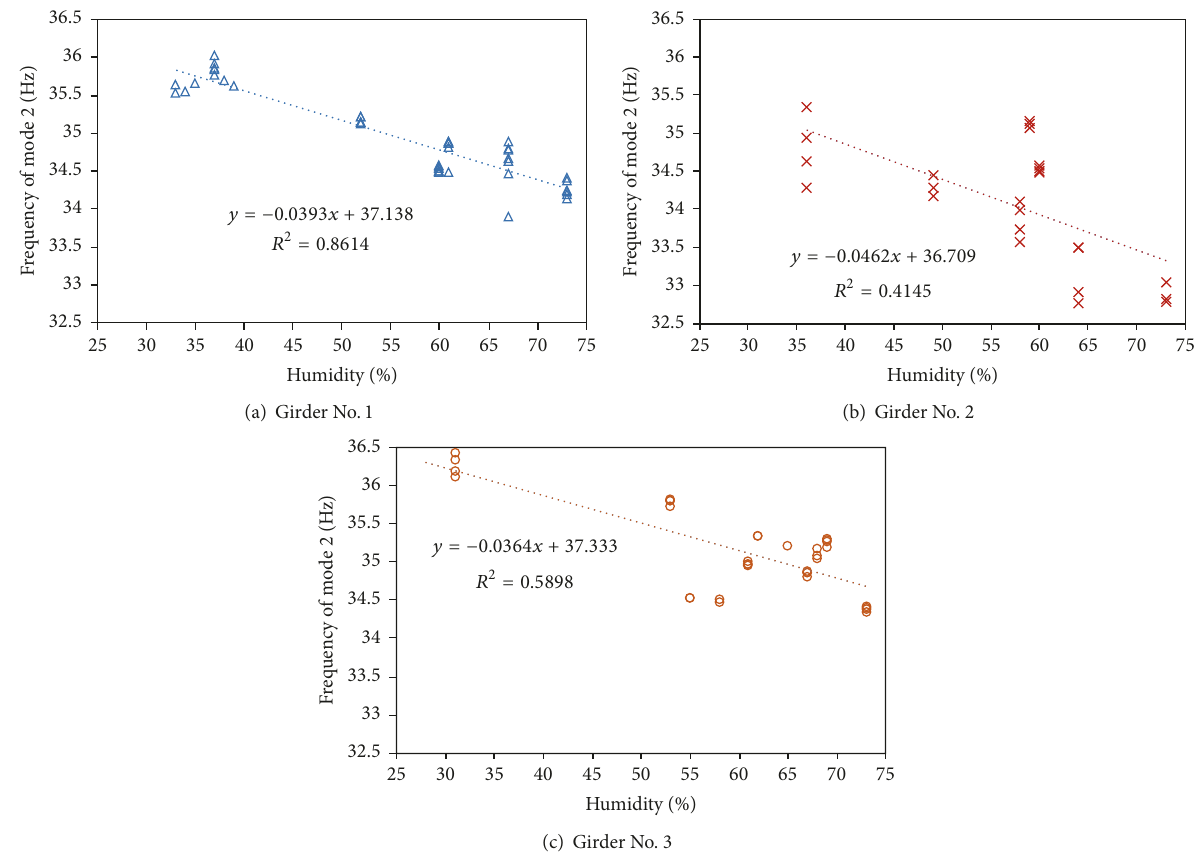
Figure 11: ((a)–(c)) Relation of frequencies of mode 2 to